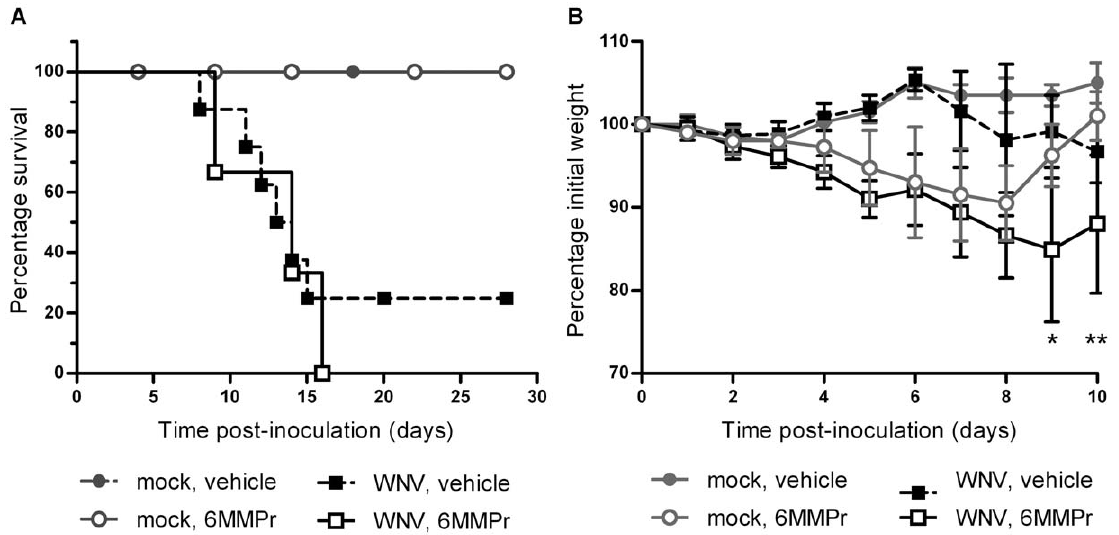
Figure 3. 6MMPr treatment of mice did not improve survival and exacerbated weight loss during WNV infection. Adult, female C3H mice were treated with vehicle or 0.5 mg 6MMPr once daily for eight consecutive days (days 0 to 7 pi). Immediately after the first treatment, mice were inoculated SC in the left rear footpad with diluent alone (mock; n=4 per group) or with 10 3 PFU of WNV (n=8 per group) and monitored daily for weight loss and clinical signs. (A) Survival data are shown. Viral infection was confirmed in all WNV-inoculated survivors by seroconversion to WNV. (B) The means 6 standard deviations of percentage initial weight are shown. Significant P values between mock-inoculated, 6MMPr-treated mice and WNV-inoculated, 6MMPr-treated mice are indicated as follows: *, P , 0.05; **, P , 0.005.